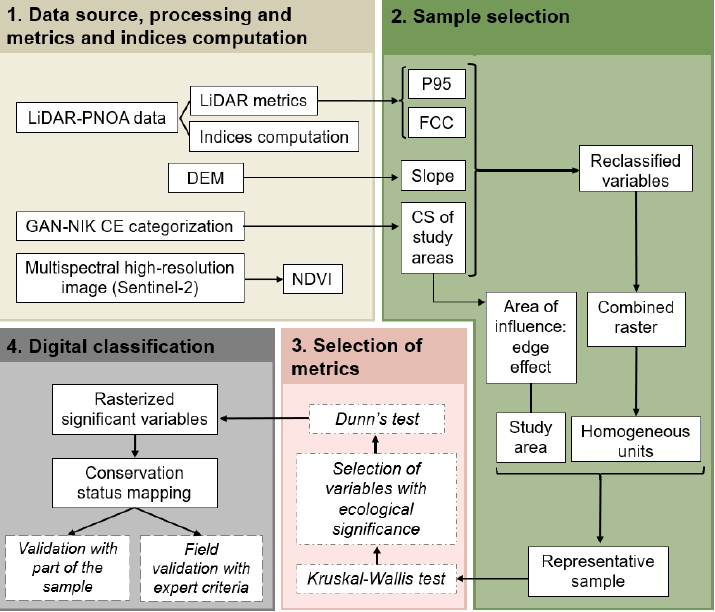
Figure 2. Methodological scheme.